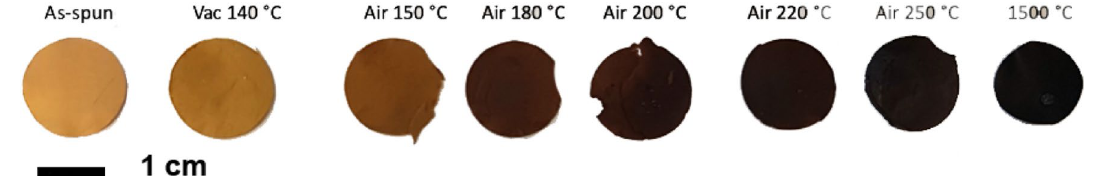
Figure 3. Colour changes in the electro-spun ASL-ESL lignin fibres before and after heat treatment at specified temperatures.